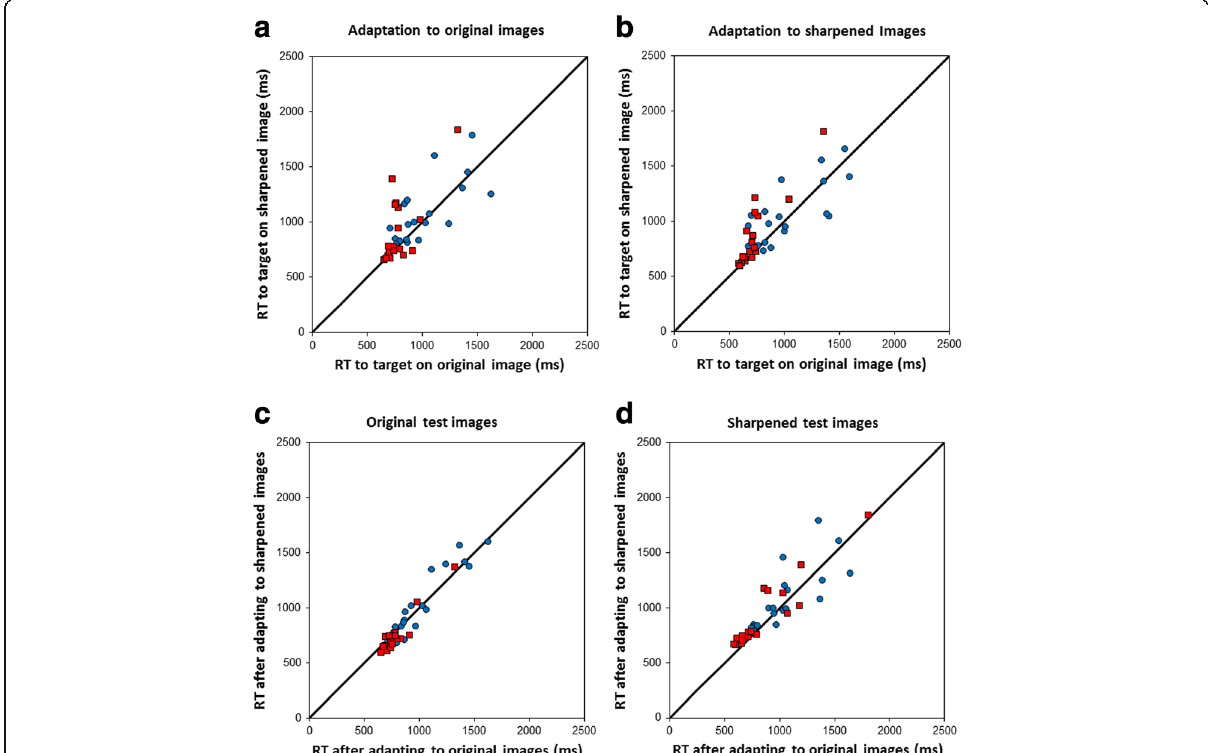
Fig. 6 Average search times for detecting targets on the original or sharpened mammogram images, after adapting to the original images or sharpened images. Points plot the mean reaction times for individual fatty ( red squares ) or dense ( blue circles ) images. Top : comparison of search times on the sharpened vs original versions of the images after adapting to the original mammogram images ( left ) or sharpened images ( right ). Bottom : search times for adaptation on the sharpened images vs the original images, compared for the original test images ( left ) or sharpened test images ( right